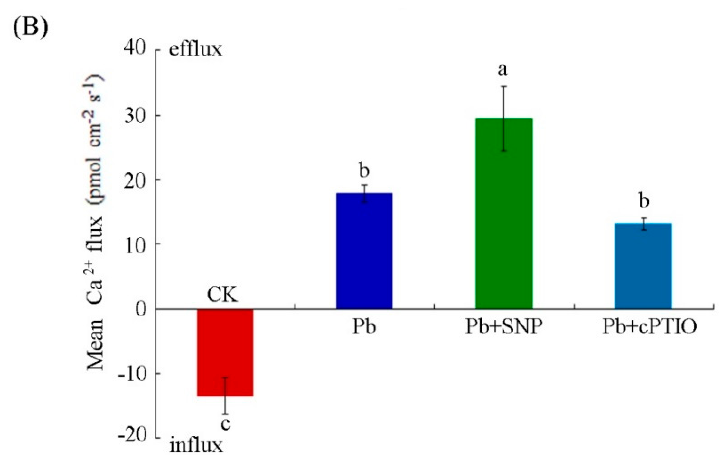
Figure 8. E ff ects of NO on Ca 2 + fluxes in tobacco BY-2 cells after di ff erent treatments for 10 h. ( A ) Net Ca 2 + fluxes in tobacco BY-2 cells treated with 250 µ M Pb(NO 3 ) 2 alone, with 0.5 µ M SNP, or with 100 Figure 8. Effects of NO on Ca 2+ fluxes in tobacco BY-2 cells after different treatments for 10 h. ( A ) µ M cPTIO. ( B ) The mean rate of Ca 2 + fluxes in tobacco BY-2 cells treated with 250 µ M Pb(NO Net Ca 2+ fluxes in tobacco BY-2 cells treated with 250 μ M Pb(NO 3 ) 2 alone, with 0.5 μ M SNP, or with with 0.5 µ M SNP, or with 100 µ M cPTIO. Cells that received the same volume of distilled water were 100 μ M cPTIO. ( B ) The mean rate of Ca 2+ fluxes in tobacco BY-2 cells treated with 250 μ M Pb(NO 3 ) 2 used as a control. Di ff erent lowercase letters show significant di ff erence ( p < 0.05). CK, alone, with 0.5 μ M SNP, or with 100 μ M cPTIO. Cells that received the same volume of distilled water were used as a control. Different lowercase letters show significant difference ( p < 0.05). CK, Control.